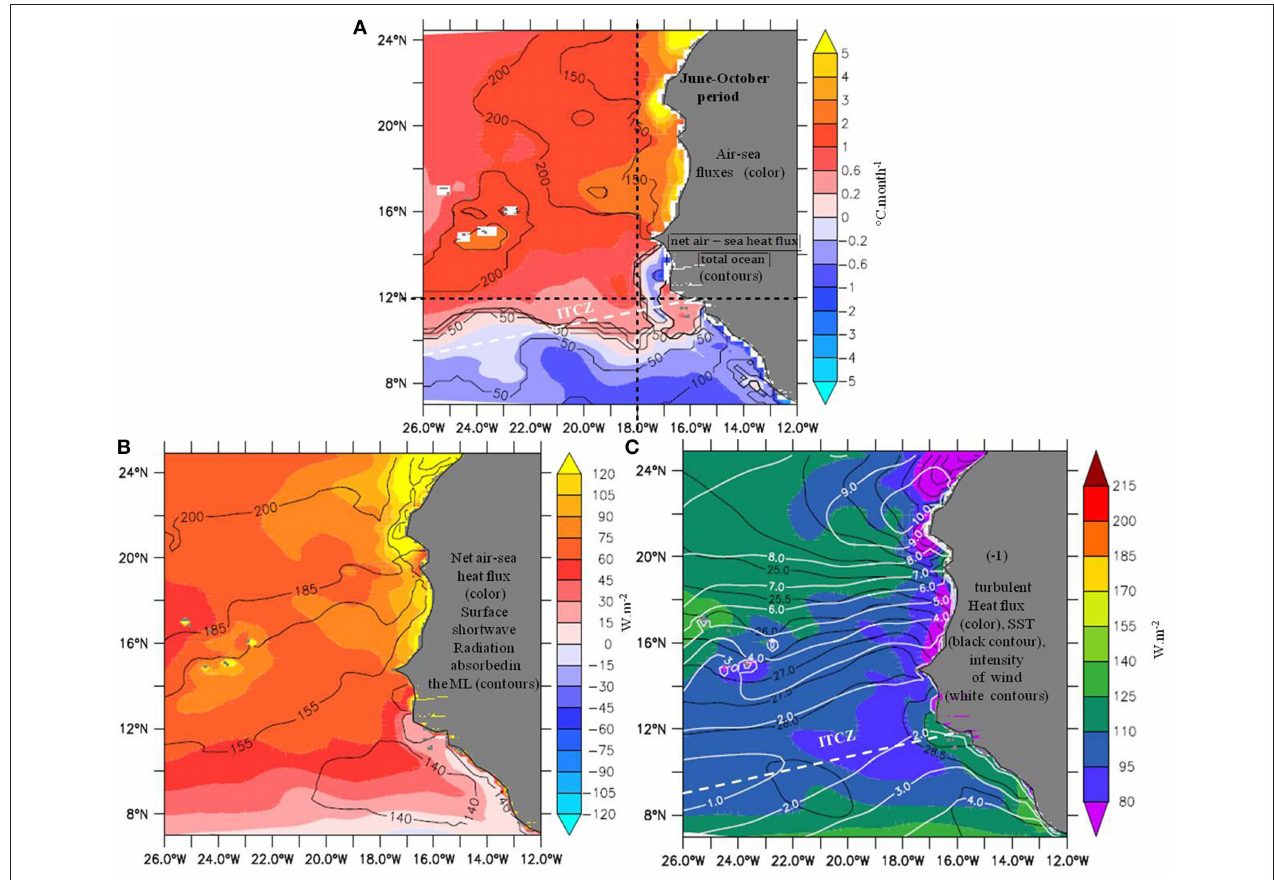
FIGURE 10 | Same as in Figure 9 but over WP